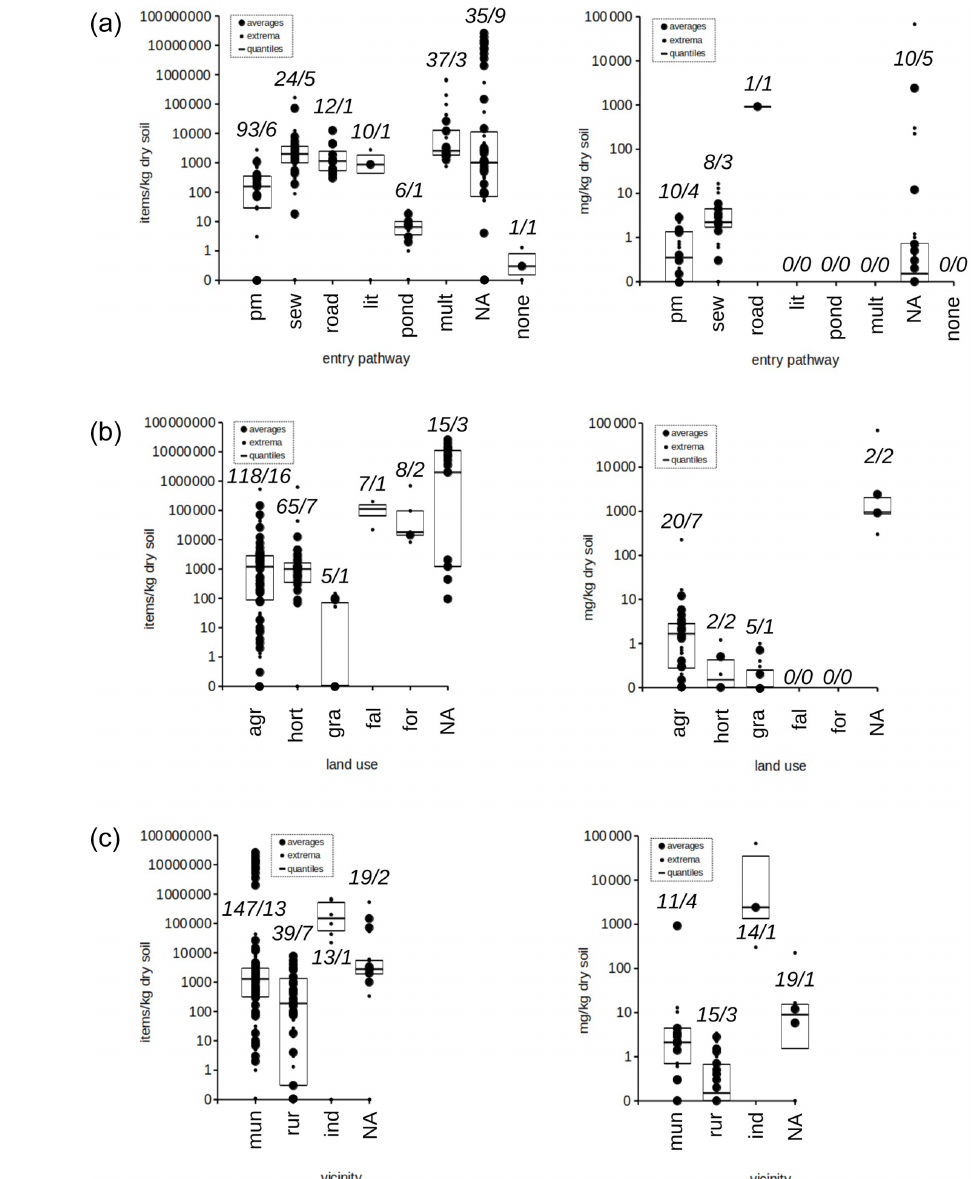
Figure 3. Concentrations of microplastics in soil ecosystems. Big dots mark median and mean concentrations measured in worldwide field experiments, small dots are the related extreme values or standard deviations, thick horizontal lines are the overall medians and narrow lines are the 25% and 75% quantile. Italicized numbers indicate the underlying number of sampling sites or studies. (a) Entry pathways are denoted as follows: pm – plastic mulching and plastic greenhousing; sew – sewage sludge and waste water application; road – road and tire wear; lit – littering; pond – ponding; mult – multiple; none – no existing entry pathways. (b) Land uses are denoted as follows: agr – agriculture; hort – horticulture and orchards; gra – grassland; fal – fallow; for – forest. (c) Vicinities of the sampling sites are denoted as follows: mun – municipal; rur – rural; ind – industrial. NA indicates data with no specification. No data were found on compost and digestate application, landfill soils or